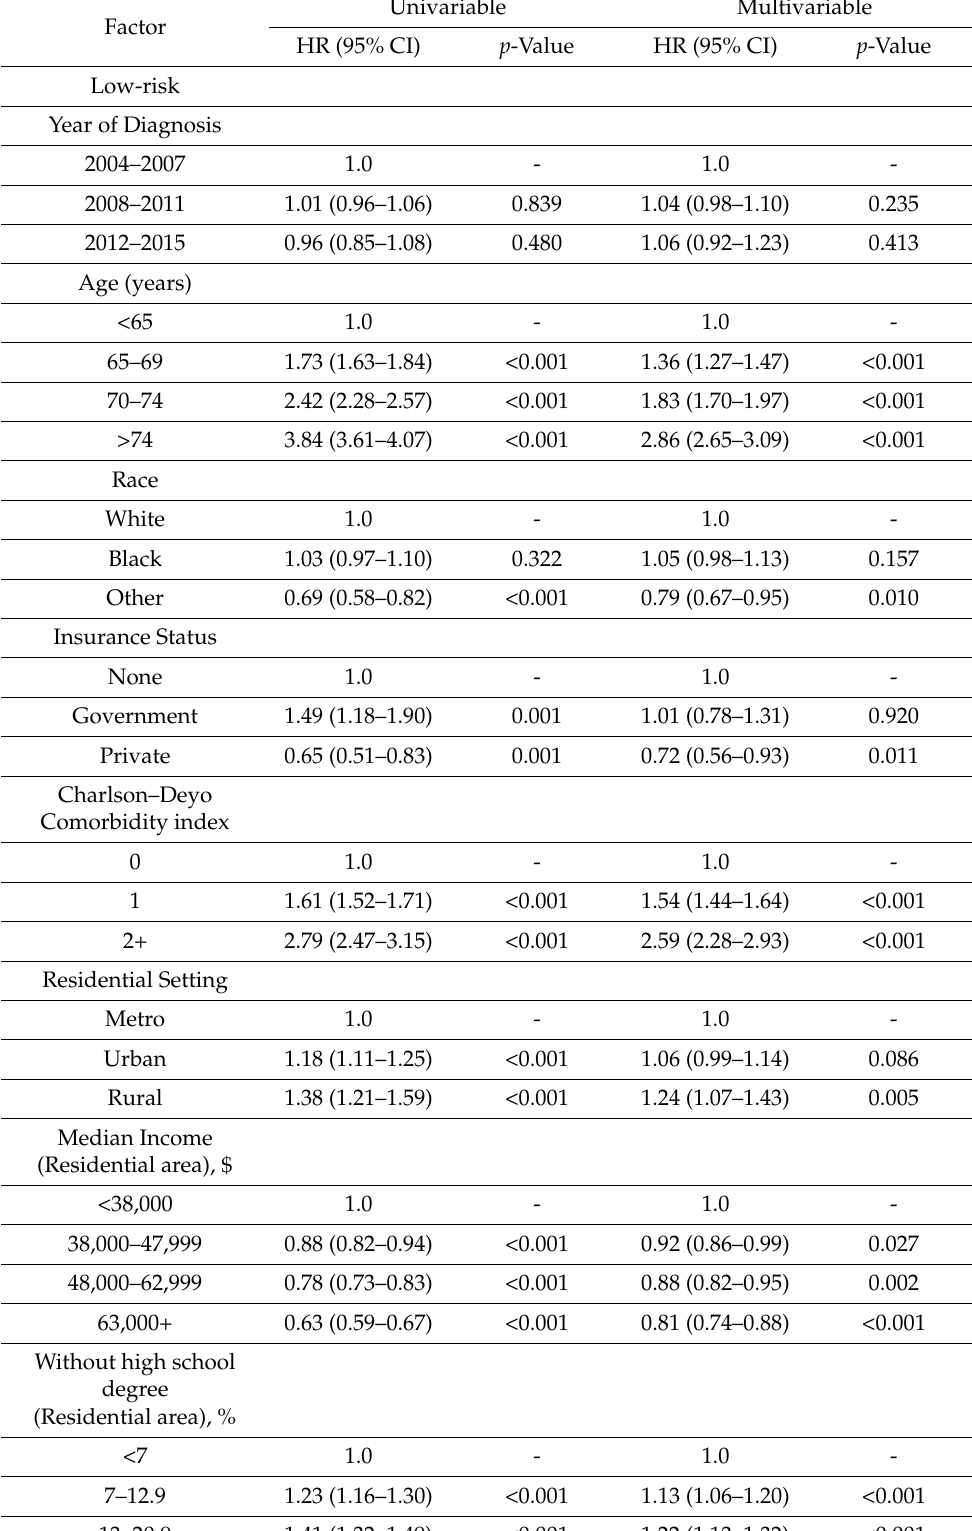
Table 6. Unadjusted and adjusted hazard ratios (HR) for respective univariate and multivariate Cox proportional hazard models of overall survival in low-risk prostate cancer patients who received one of the six